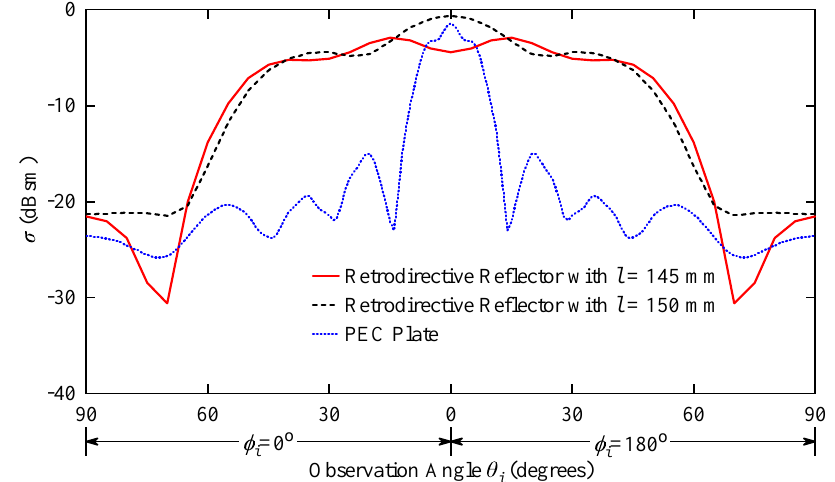
Figure 17. The monostatic RCSs of a retrodirective array with two different transmission line lengths compared to the monostatic RCS of a PEC plate of the same size.